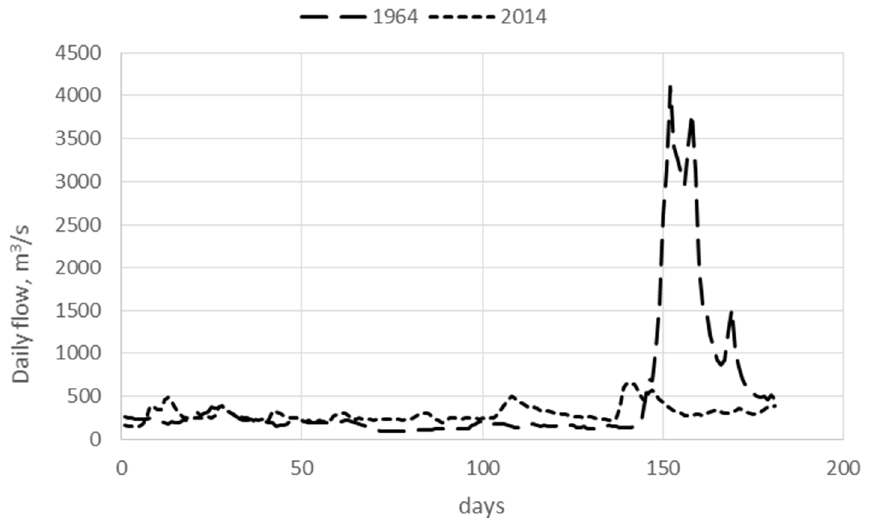
Figure 5. Hydrographs of daily flow in winter of 1964 and 2014.